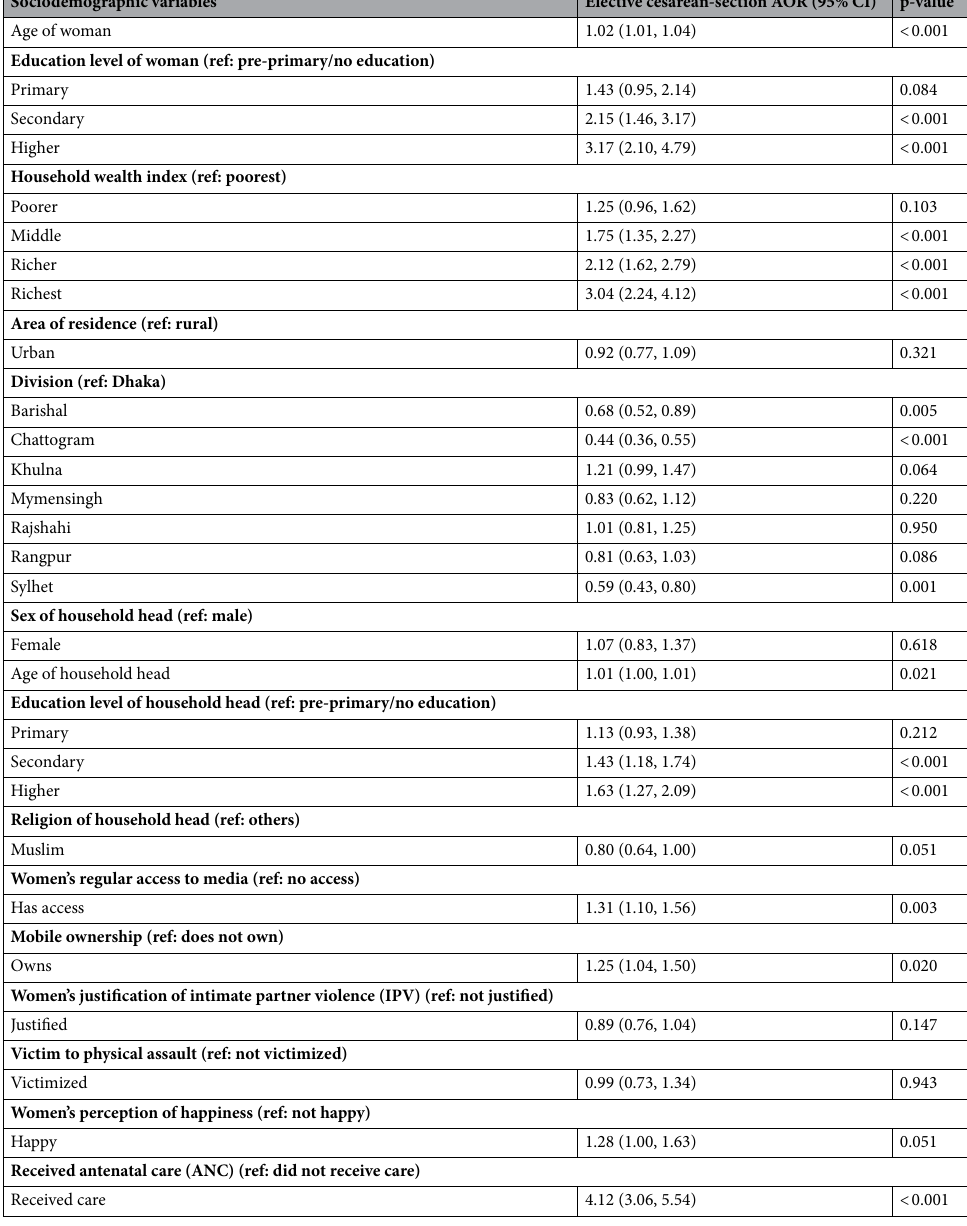
Table 2. Generalized Linear Model (GLM) fitted to binary outcome variable ‘elective cesarean section’ (binary) with sociodemographic variables adjusting for cluster and strata-wise variations and survey weights. AOR adjusted odds ratio, CI confidence